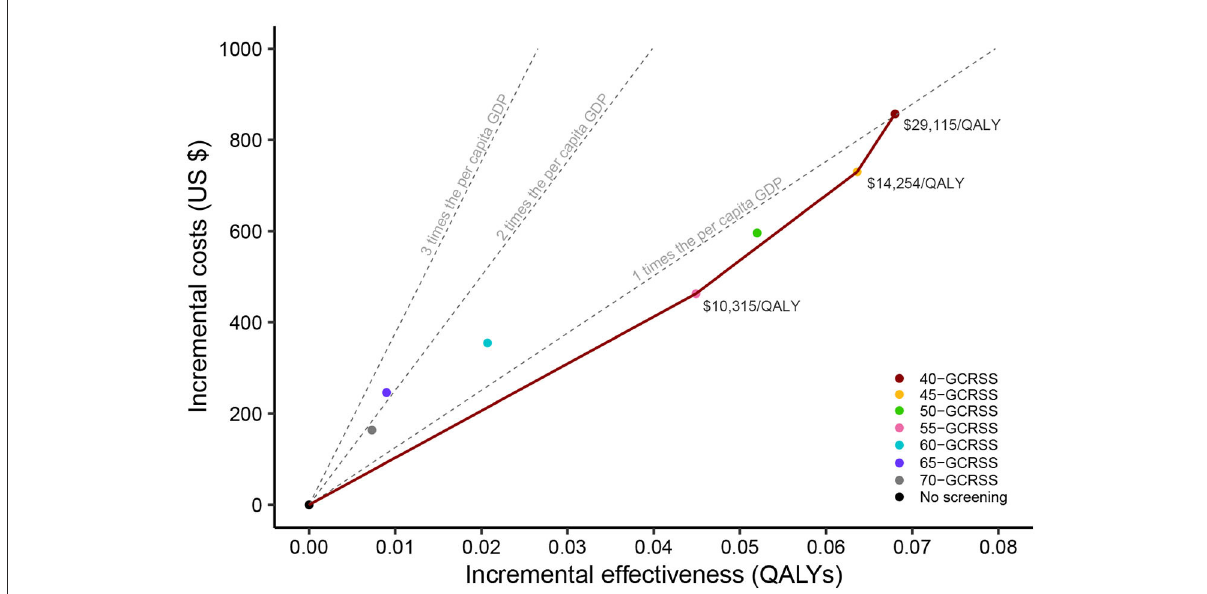
FIGURE4 Tornado diagram on one-way sensitivity analysis of the 40-GCRSS strategy compared with no screening. RR, relative risk; G-17, gastrin-17; ESD, endoscopic submucosal dissection; Hp, Helicobacter pylori ; ICER, incremental cost-effectiveness ratio; QALY, quality-adjusted life year.